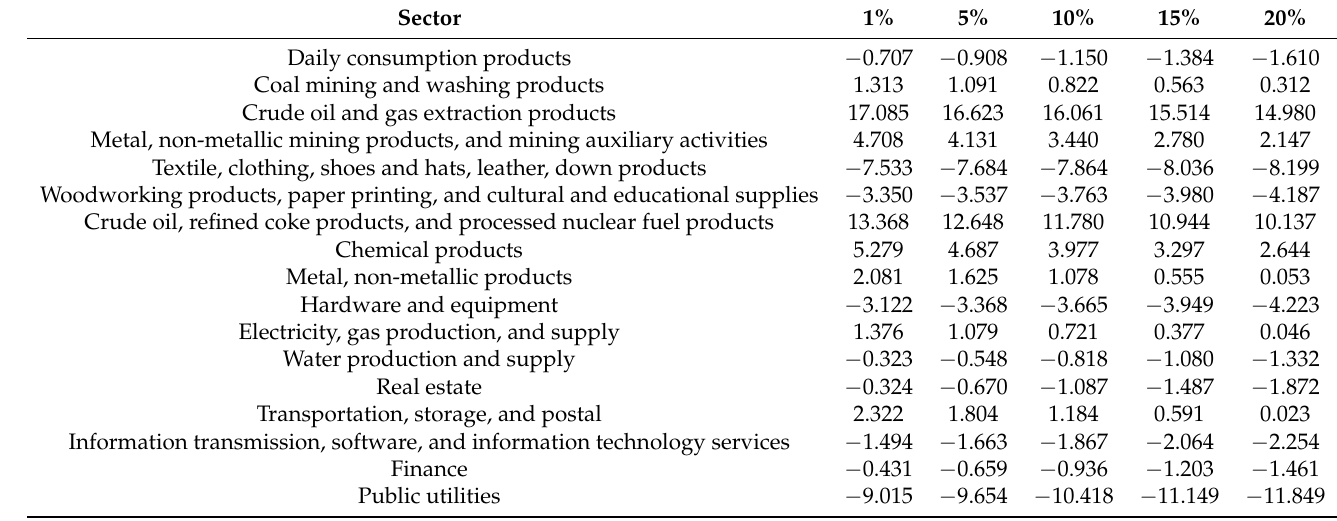
Table A11. Household consumption change rate after the rise in crude oil